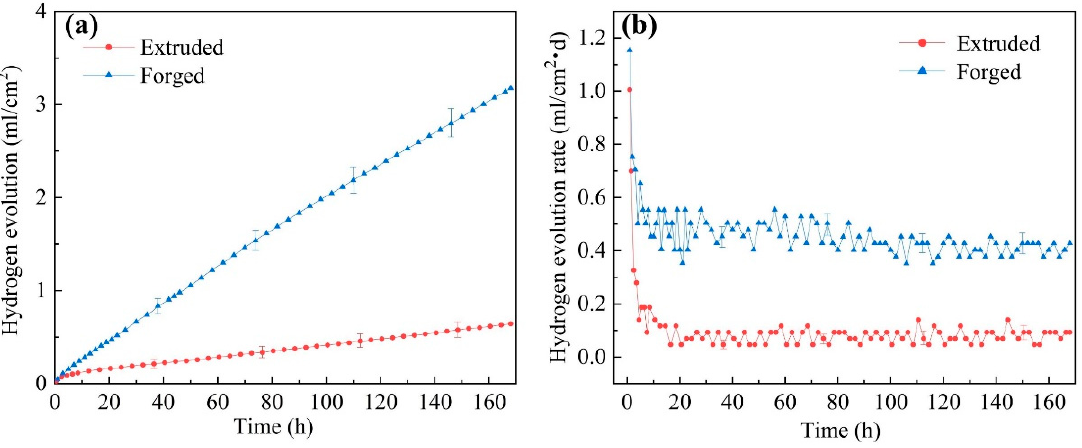
Figure 9. Average hydrogen evolution amount ( a ) and rate ( b ) of WE43 alloys in 0.6 M NaCl solu- tion.